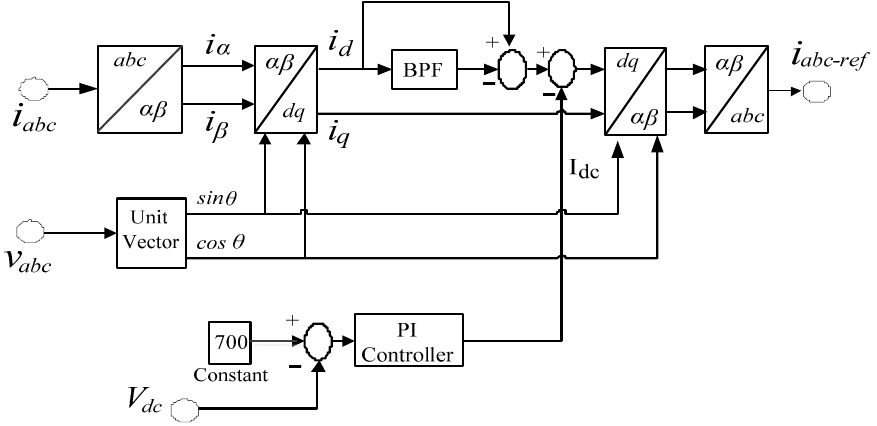
Figure 2. Block diagram of modified synchronous reference frame (MSRF) method.